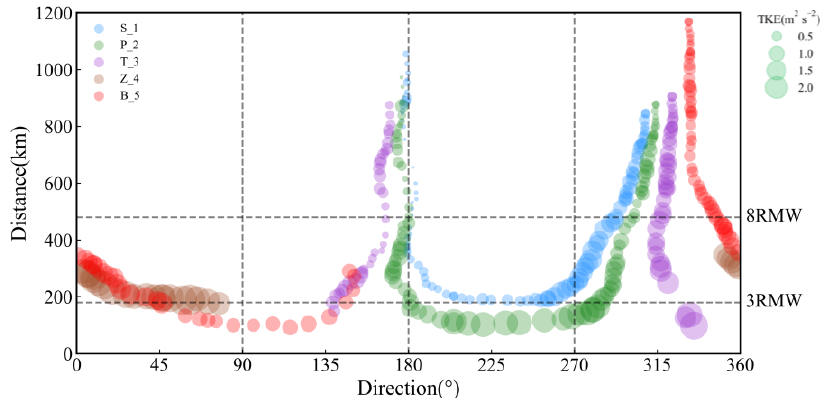
Figure 8. TKE of each DWL as a function of the orientation and distance from the typhoon center. Different colors represent different DWLs, and the size of the scattered points represents the size of the TKE value (m 2 s − 2 ). Table 3. Mean TKE (m 2 s − 2 ) of each DWL located at different stages of the typhoon center before and after landfall.